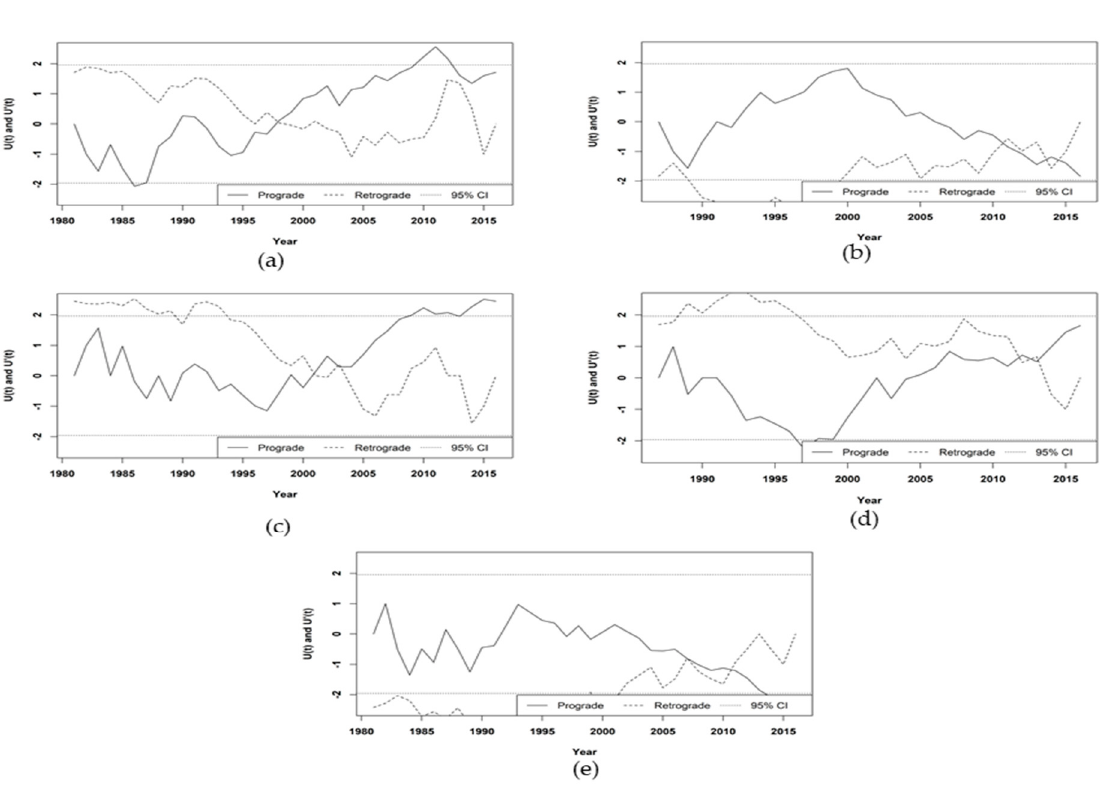
Figure 3. Sequential Mann–Kendall plots for ( a ) Anantapur, summer; ( b ) Brahmasamudram, northeast monsoon; ( c ) Gooty, summer; ( d ) Puttaparthi, summer; and ( e ) Singanamala, northeast monsoon.